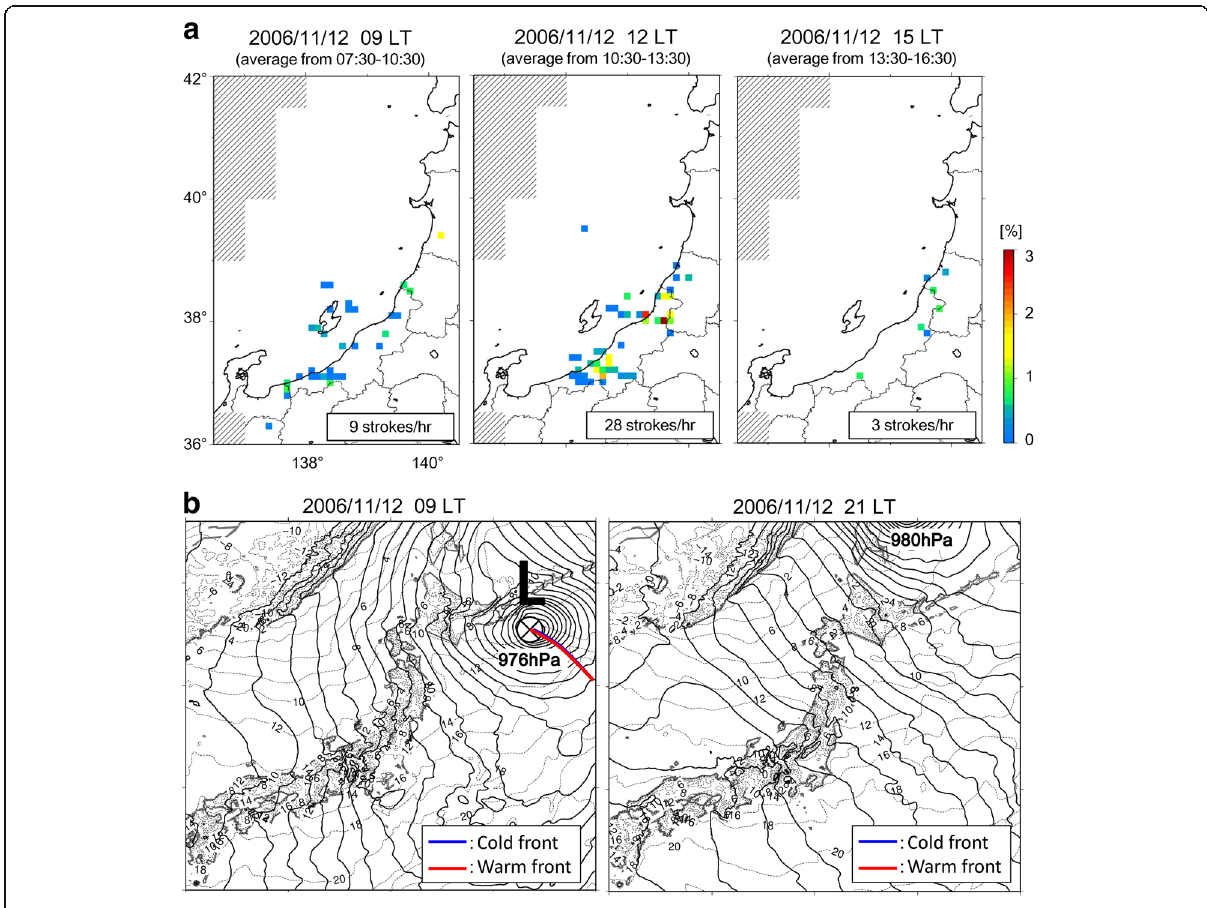
Fig. 16 a , b Similar to Fig. 10 but for case C